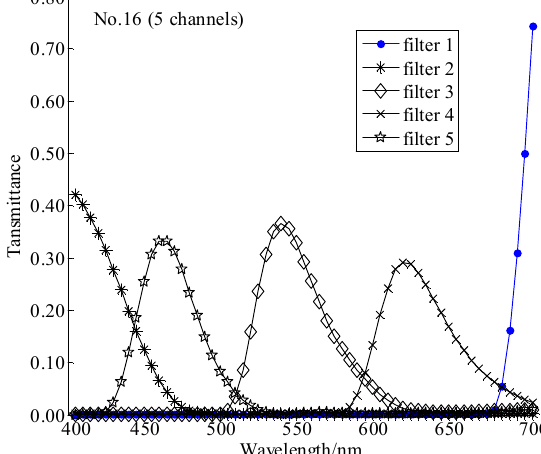
Figure 7. Transmittances of the best-performed filter sets, No. 16 (5), under CIE standard illuminant A according to the cumulative scores listed in Table 6.